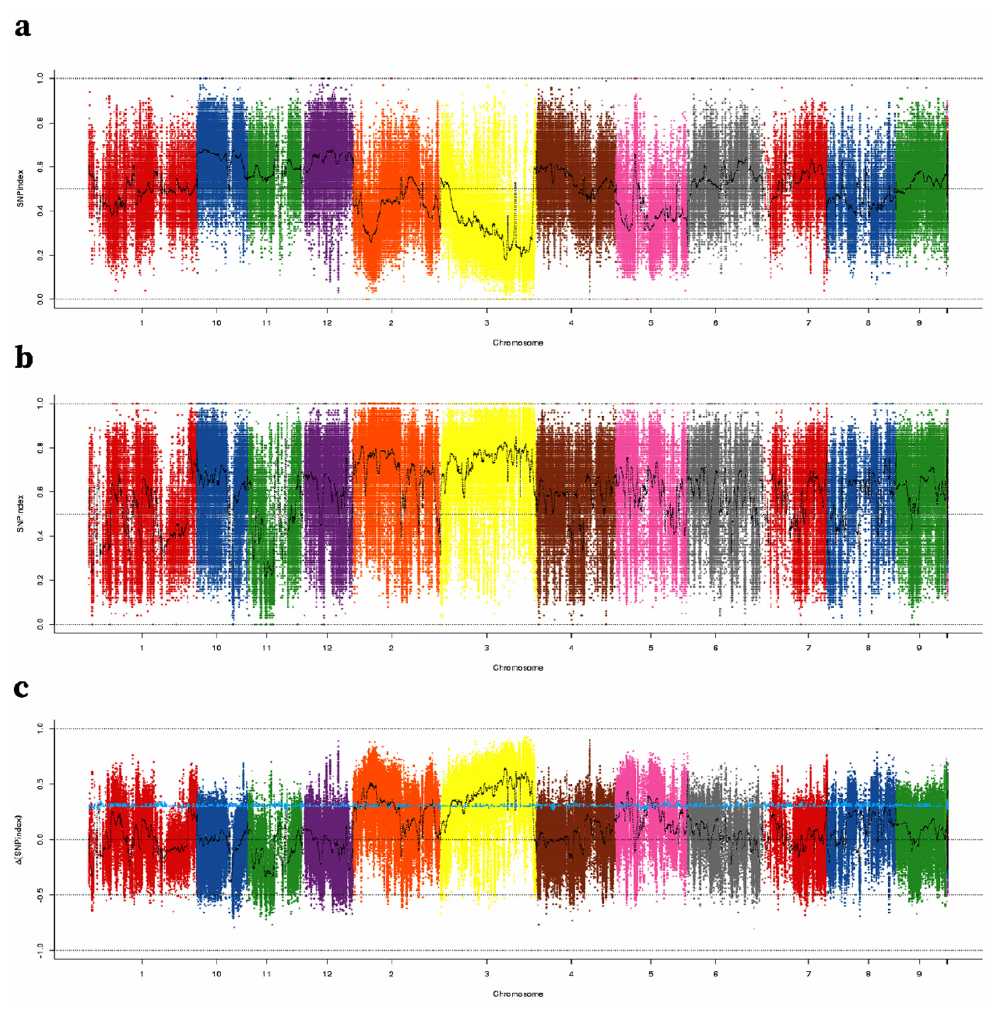
Figure 3. SNP-index Manhattan plot of B-pool, S-pool, and ∆ (SNP-index) from the BSA analysis. SNP-index graphs of ( a ) big-grain bulk and ( b ) small-grain bulk. ( c ) ∆ (SNP-index) graph. The X-axis shows the position of the 12 chromosomes and the Y-axis shows the SNP-index ( a , b ) and ∆ (SNP-index). The blue line is the screening threshold at a 95% confidence level. SNPs are set to different colors to help distinguish chromosomal boundaries.